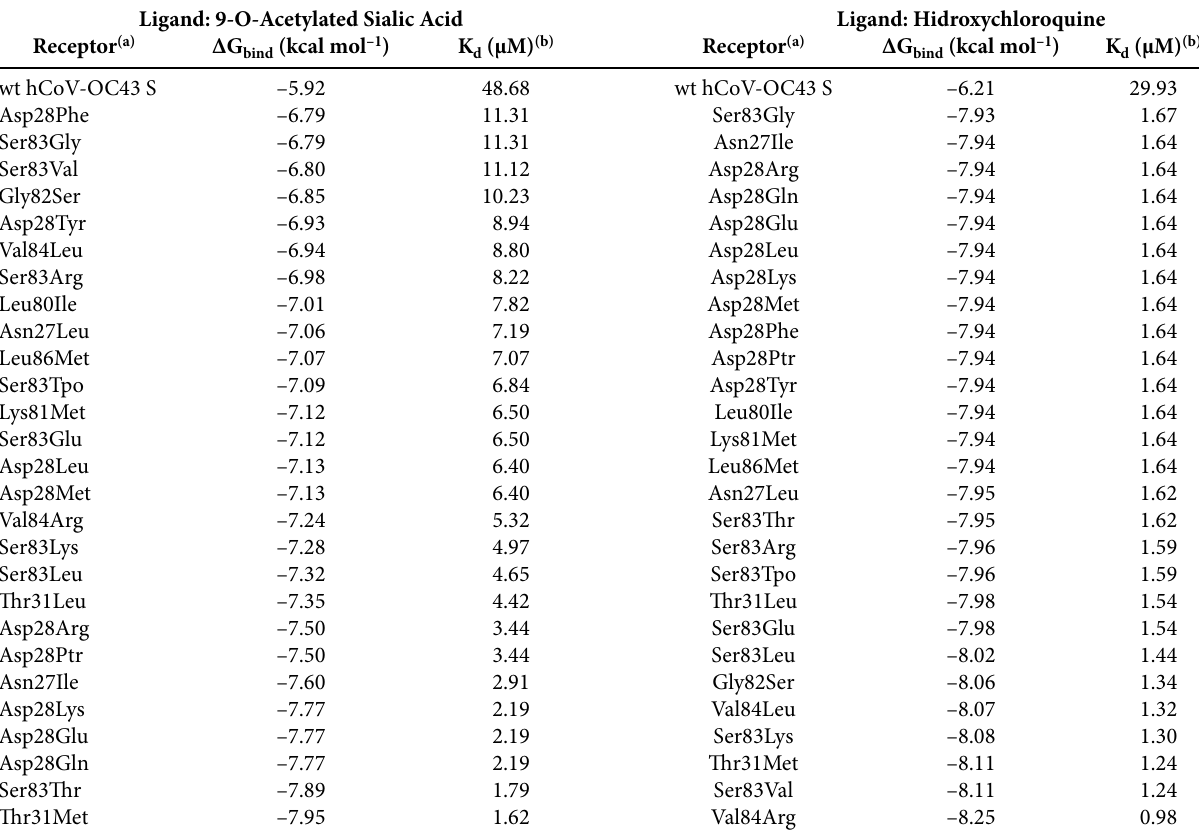
Table 1. The Binding Free Energies Obtained by Docking 9-O-Ac-Sia and Hcq in the Single Point Mutants of hCoV-OC43 S (PDB ID: 6NZK) Ligand: 9-O-Acetylated Sialic Acid Ligand: Hidroxychloroquine